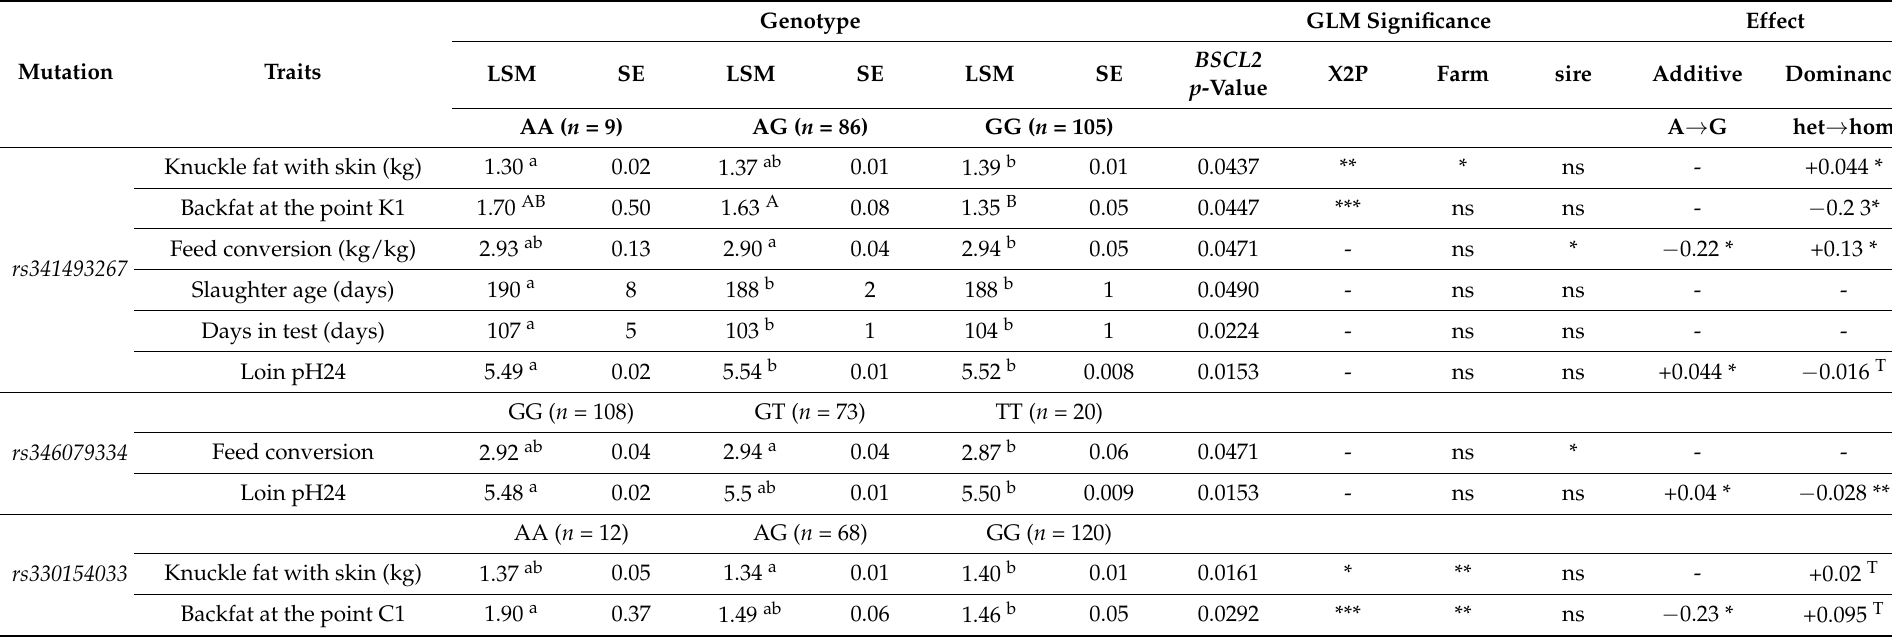
Table 6. Means as least-square means (LSM) with standard error (SE) for pig production traits dependent on BSCL2 genotypes for Polish Landrace.